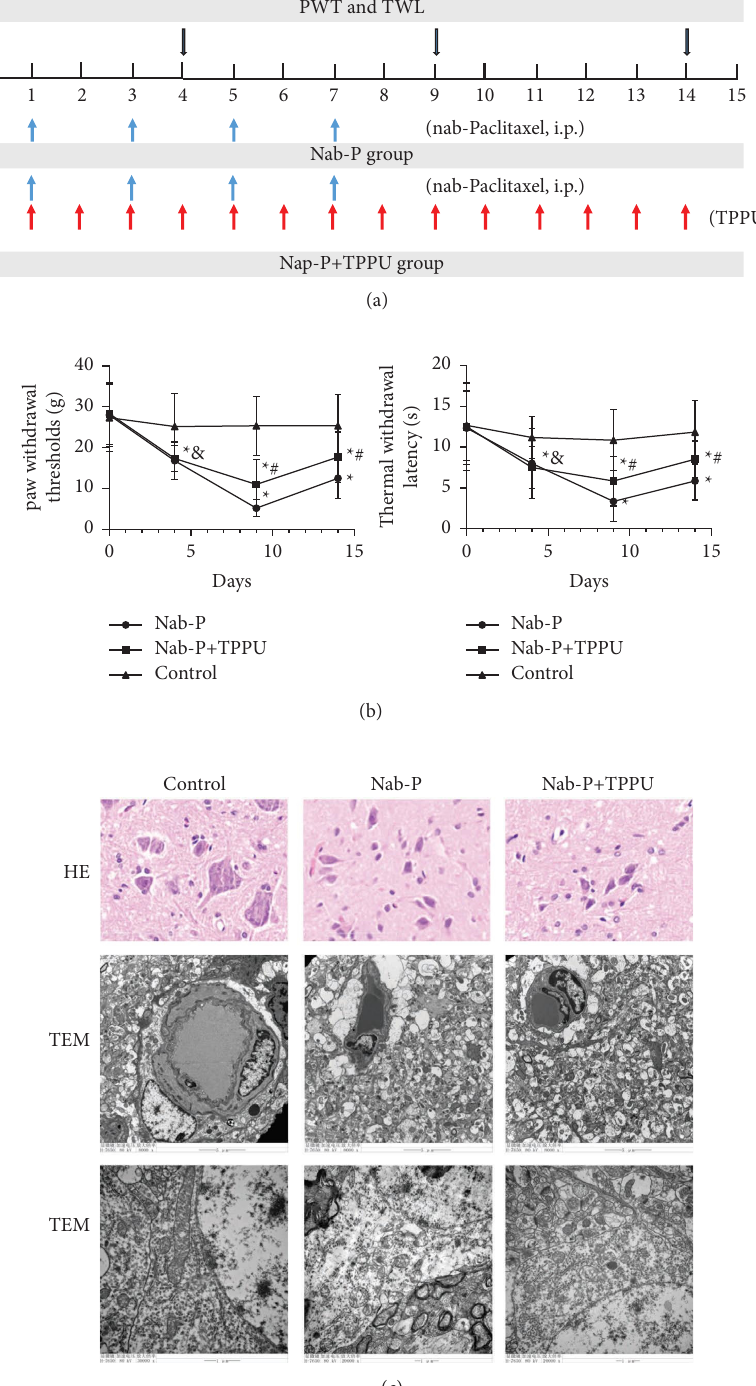
Figure 1: TPPU alleviated nab-paclitaxel-induced mechanical, heat hypersensitivity, and pathological changes. (a) Schematic diagram of the experimental procedure. Nab-P, nab-paclitaxel; TPPU, N-(1-(1-oxopropy)-4-piperidinyl]-N ′ -(trifuoromethoxy)phenyl)-urea; i.p., in- traperitoneally; PWT, paw withdrawal mechanical threshold; TWL, thermal withdrawal latency. Blue arrows indicated the timepoint when nab-P was treated on rats, while red arrows indicated when TPPU was treated on rats. (b) PWTand TML of each group ( n � 6) at d0, d4, d9, and d14. ∗ P < 0 . 05 compared to the control group, # P < 0 . 05 compared to the nab-P group, and & P > 0 . 05 compared with the nab-P group. (c) H and E staining (scale bar � 100 μ m) and TEM (scale bar � 5 μ m and 1 μ m) were used to detect the pathological changes in the spinal cord of a